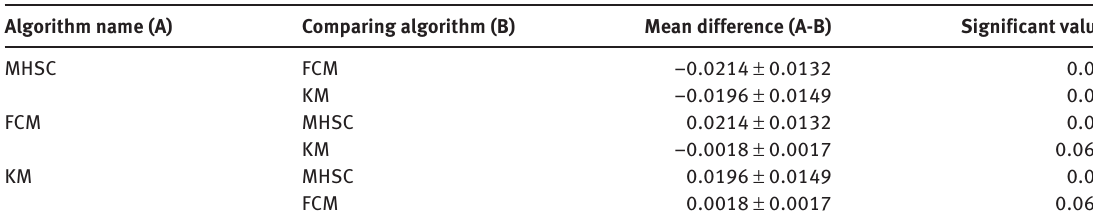
Table 10: Estimated Means and Pairwise Comparisons of Different Algorithms on the Minkowski Score Obtained by ANOVA Testing for the CMC Dataset.